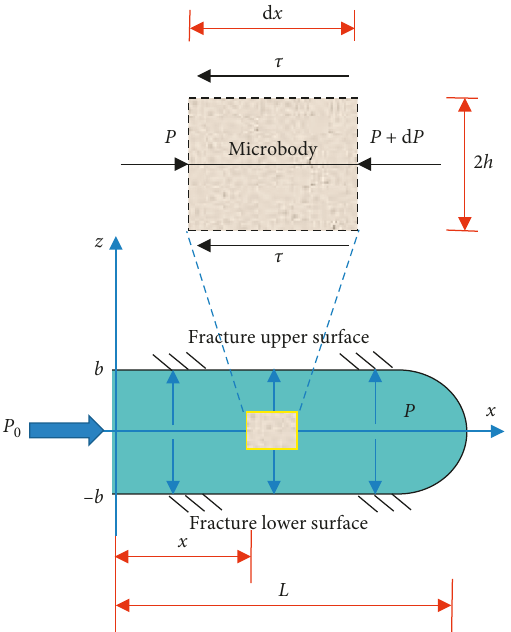
Figure 3: Element body equilibrium